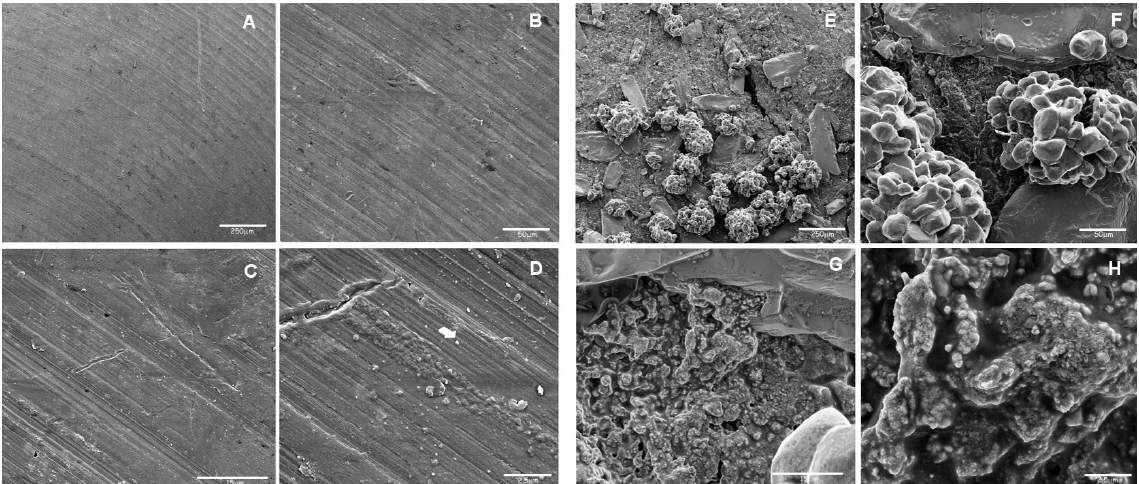
Figure 2. Surface photomicrographs of quasi- and all-solid-state reference electrodes containing 45% w/w C graphite /Ag/AgCl (from a to d ) and 3.0molkg − 1 KCl (from e to h ), respectively. Magnifications are for (a) and (e) 200 × , (b) and (f) 1000 × , (c) and (g) 5000 × , and (d) and (h) 20000 ×